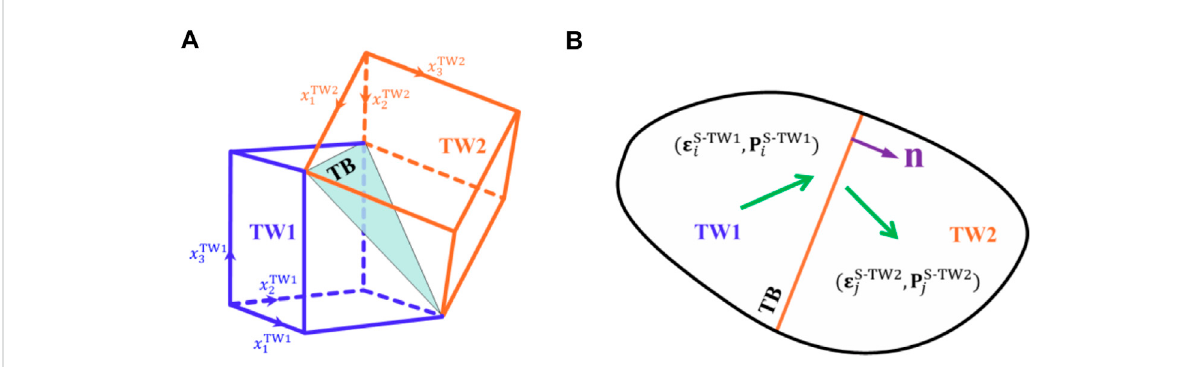
FIGURE 1 (A) Schematic of the tetragonal ferroelectric twin structure, where twin boundary (TB) represents the twin plane, TW1 and TW2 respectively denote the symmetric unit cells about the twin boundary. x TW1 1 x TW1 2 x TW1 3 and x TW2 1 x TW2 2 x TW2